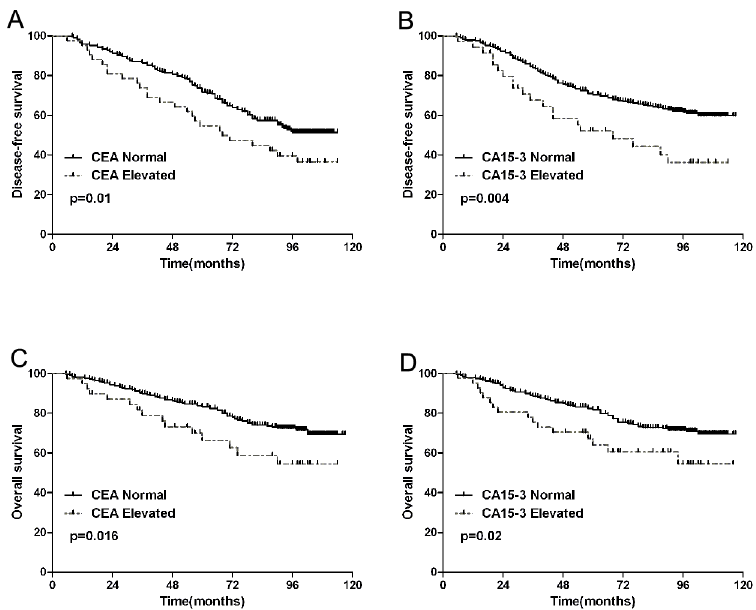
Fig 2. Kaplan-Meier survival curves of Luminal B breast patients with normal or elevated CEA and CA15-3 levels. DFS according to CEA(A) and CA15-3(B), OS according to CEA(C) and CA15-3(D).